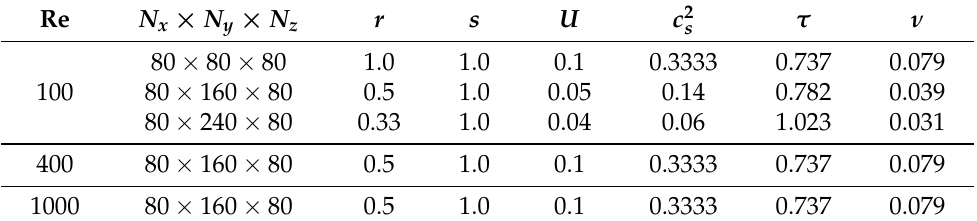
Table 2. Parameters used in the simulation of 3D lid-driven cubic cavity flow using 3DCCM-LBM. Re